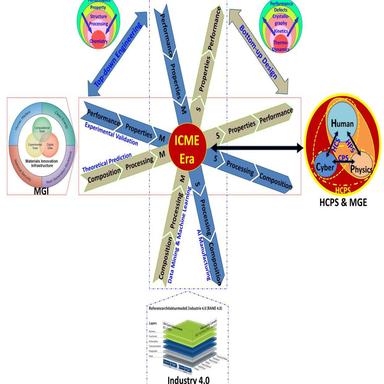
Digital-twin design paradigm in the integrated computational materials engineering (ICME) Era. The schematic images of top-down engineering and bottomup design are reported in Ref.. The images of Materials Genome Infrastructures (MGI) of US, Human-Cyber-Physics system (HCPS) & Materials Genome Engineering (MGE) of China, and Industry 4.0 of Germany are reported in Refs. , and respectively. The abbreviation MS in the designing routine means microstructure.